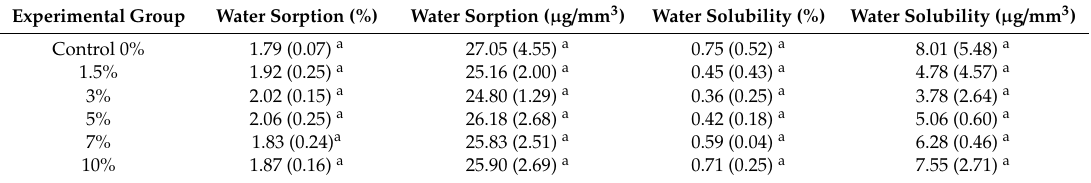
Table 2. Mean and standard deviation values of sorption ( µ g / mm 3 ) and percentage of sorption (%) after 90 days of storage in distilled water; solubility ( µ g / mm 3 ) and its percentage (%) values after 180 days.